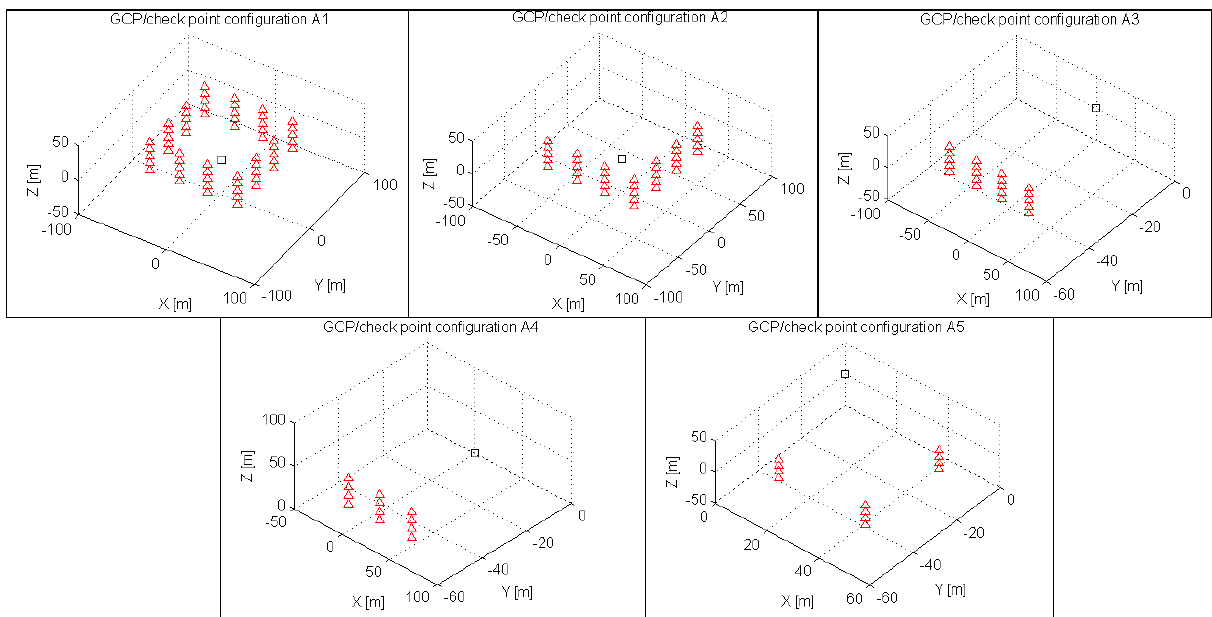
Figure 1. – GCP configurations adopted in Monte Carlo simulations to assess different stochastic